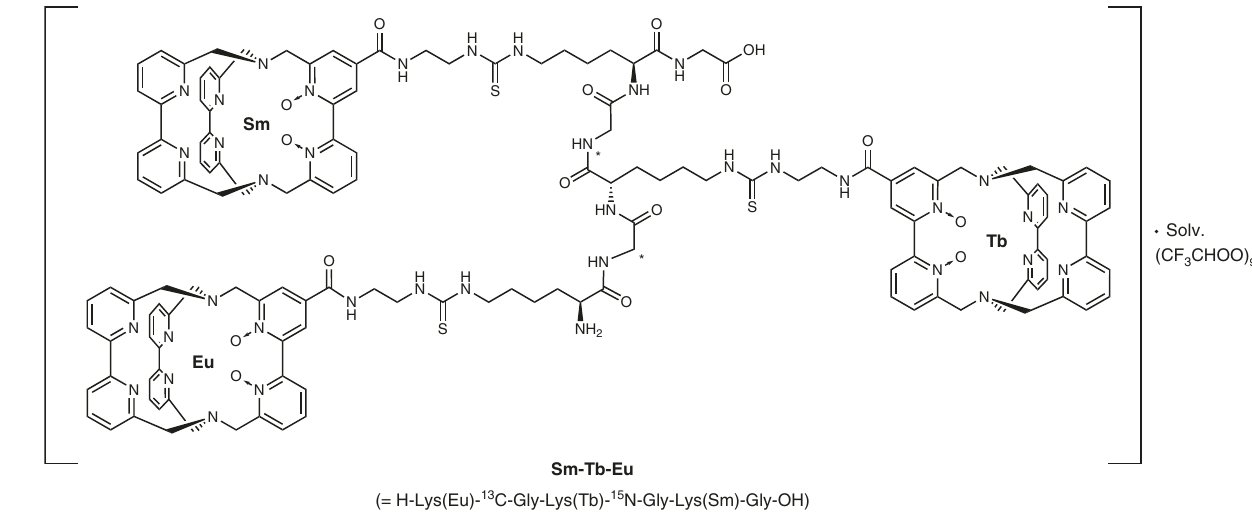
Fig. 6 Heterotrimetallic Nanocode. Chemical structure of the nanocode Sm-Tb-Eu .